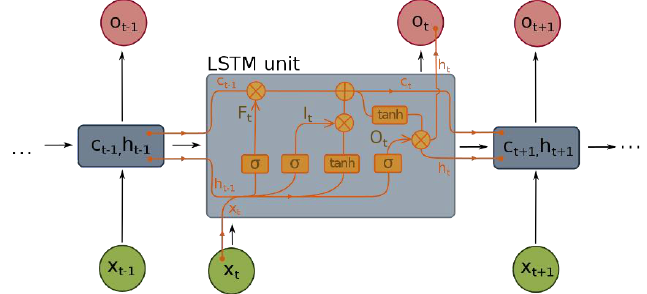
Figure 7. The hidden state interactions in an LSTM model.